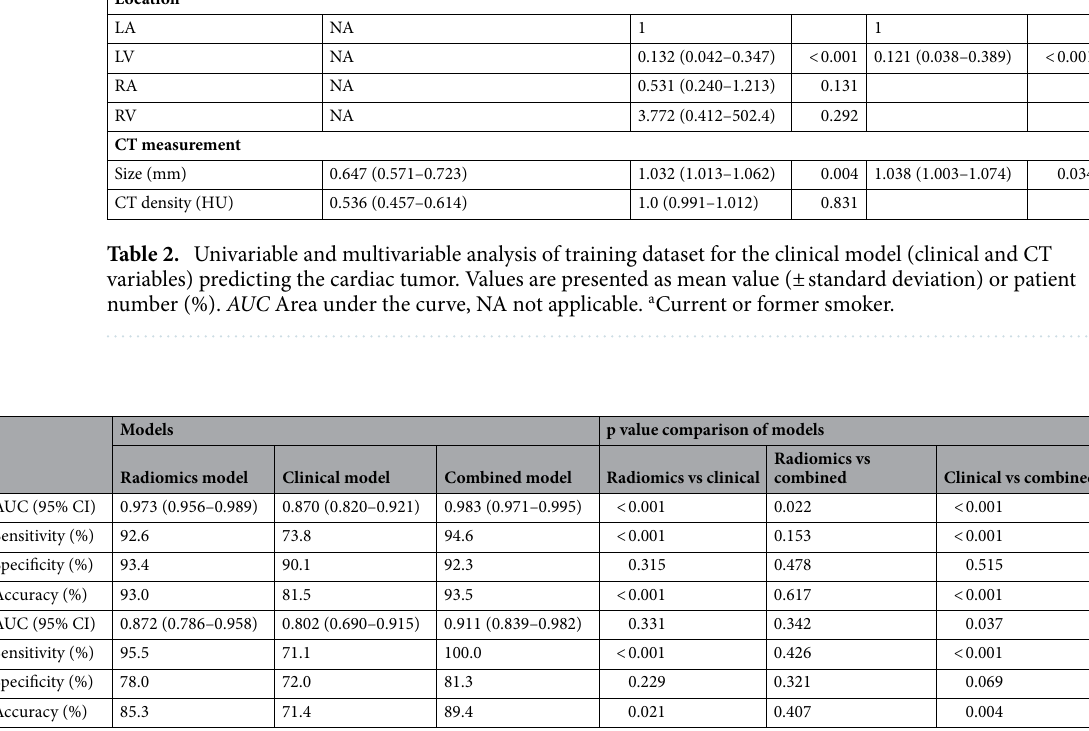
Table 3. Discrimination performance of radiomics, clinical, and combined (radiomics plus clinical model) models in training and validation datasets. AUC area under the curve, NA not applicable.